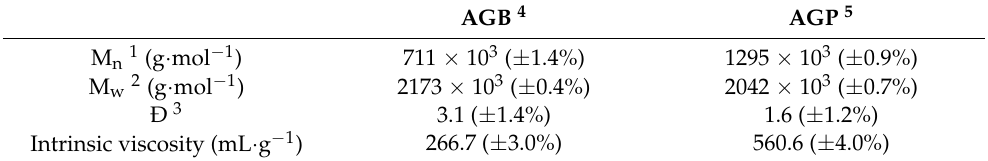
1 M n : number average molecular weight. 4 AGB: sulfated glycoprotein (crude extract) from C. decorticatum . 5 AGP: sulfated glycoprotein (purified extract) from C. decorticatum